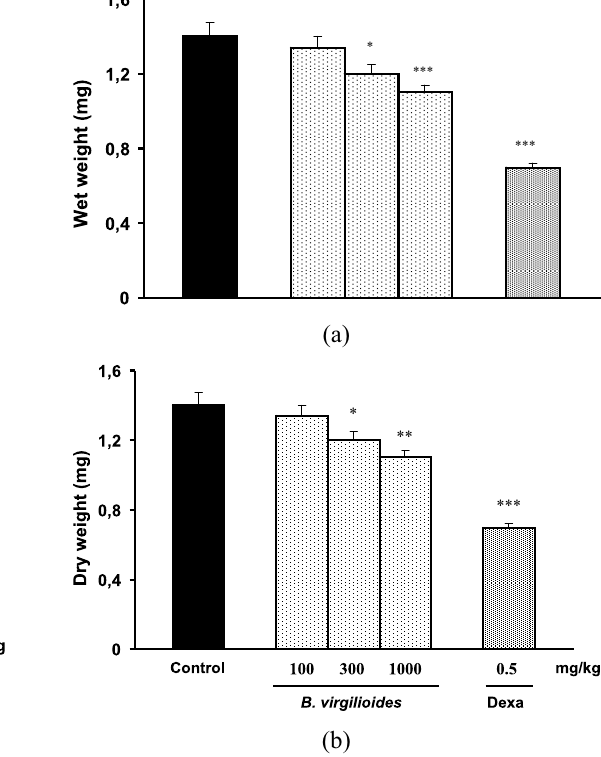
Fig. 1 – Effect of ethanolic extract of B. virgilioides on exudate volume (a) and leukocyte (b) accumulation in carrageenan-induced pleurisyinrats. Vehicle, Bowdichiavirgilioides , 100, 300, 1000mg/kg and dexamethasone 0.5 mg/kg. Each column represents the mean ± S.E.M.of9-10animals. *p < 0.005; **p < 0.01, ***p < 0.001(One-way ANOVA followed by Student-Newman-Keul’s test).